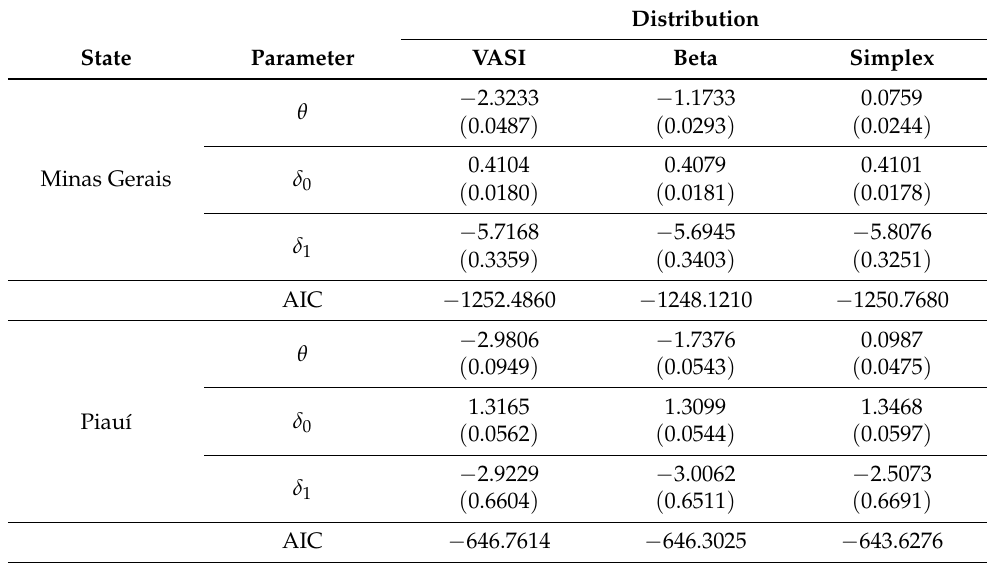
Table 9. ML estimates (with SEs in parentheses) and AIC values for the vote